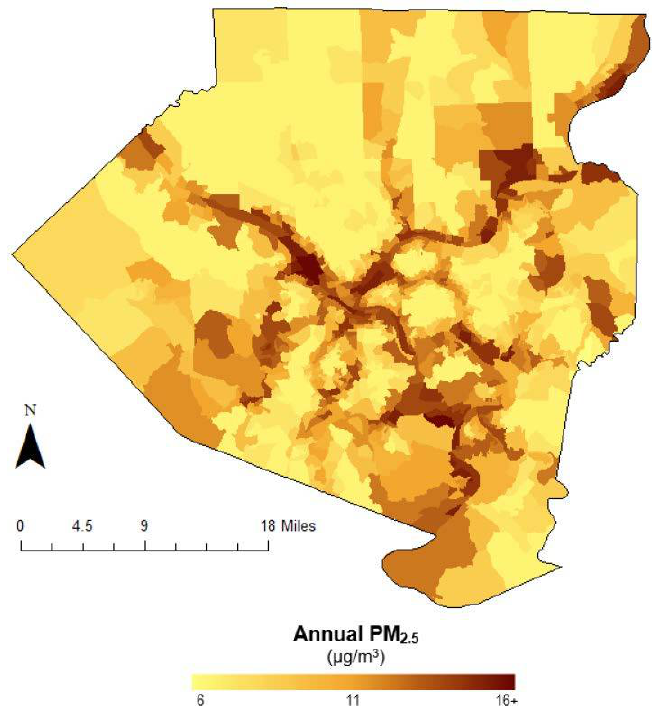
Figure 1. Annual PM 2.5 concentrations by census block group in Allegheny County, PA. Values Annual PM 2.5 concentrations by census block group in Allegheny County,